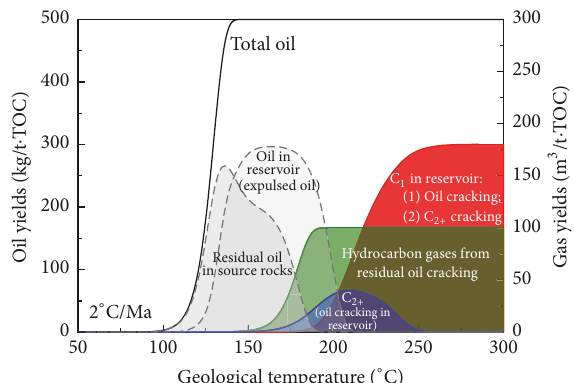
Figure 6: Gas generation model for the cracking of residual oil in Type-II source rocks and expelled crude oil in reservoir under geological conditions (heating rate: 2 ∘ C/Ma). The conversion of the generation and cracking of oil and gas were obtained by kinetic extrapolation based on their kinetic parameters, wherein the kinetic parameters ( 𝐸𝑎 and 𝐴 𝑓 ) applied in this model for oil generation were 51.4 kcal/mol and 8.14𝐸+13 s −1 [9], for oil cracking in reservoir were 59.8 kcal/mol and 2.13𝐸 + 13 s −1 [2], and for residual oil cracking in source were 56.1 kcal/mol and 1.0𝐸 + 13 s −1 [61]. Previous studies revealed that the average